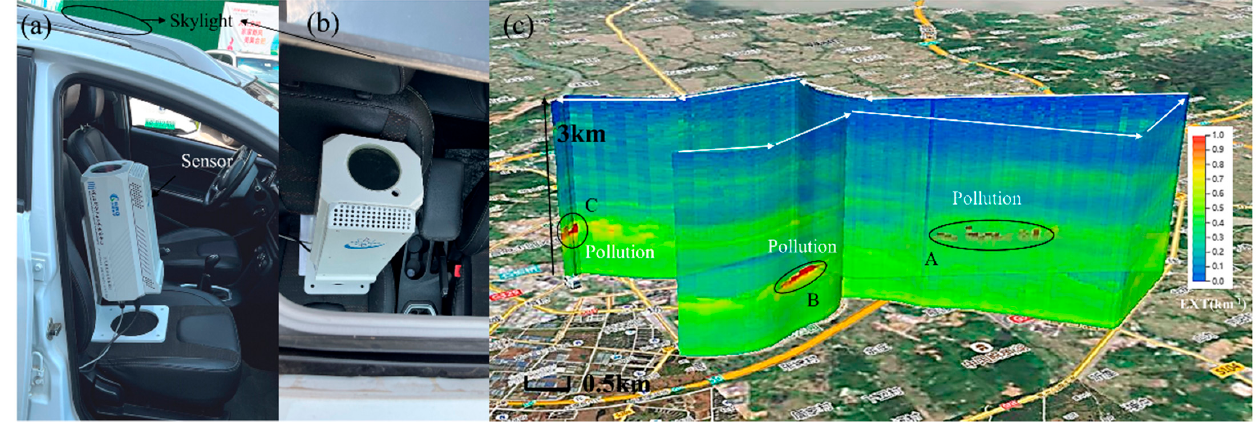
Figure 13. ( a , b ) Photo of mIRLidar system, and ( c ) extinction maps in Navigation detection mode on 25 April 2022, in Quanzhou (UTC+8). 25 April 2022, in Quanzhou